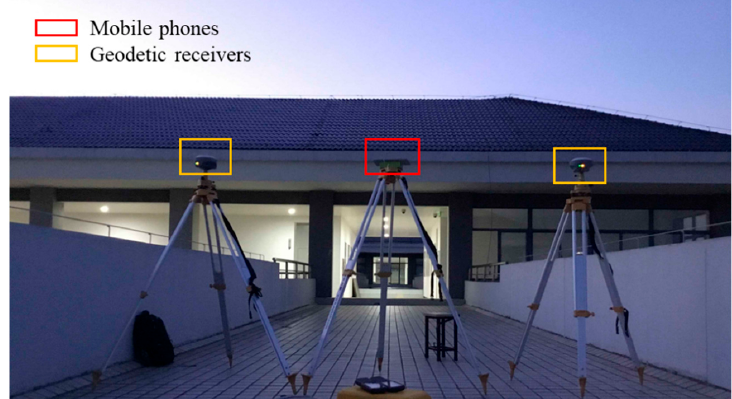
Figure 1. Mobile phones and geodetic receivers at the site of first and third dataset. There is a plastic board on the top of the middle tripod, and smartphones are placed on the board.